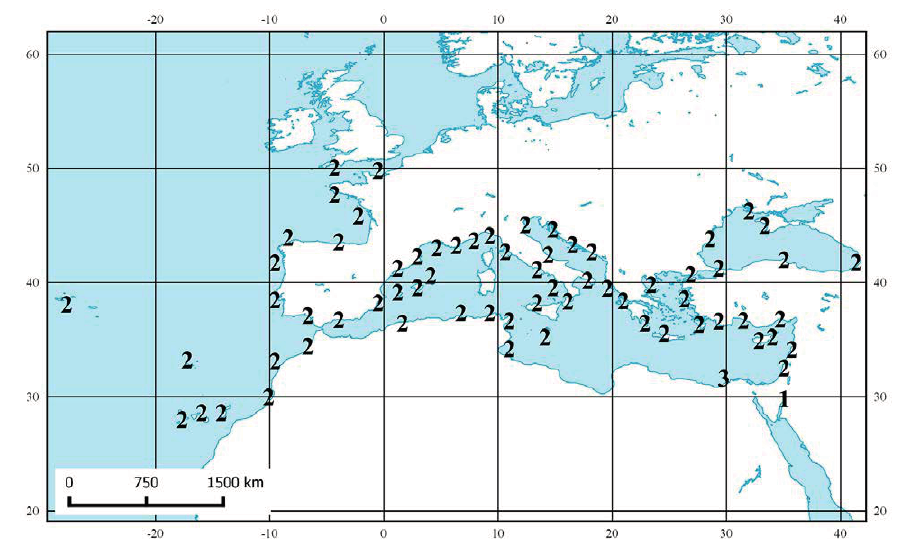
Fig. 2. – Geographical distribution of the Scorpaena decemradiata n. sp. and S. porcus Linnaeus, 1758 in the eastern Atlantic, Mediterranean Sea and Red Sea. 1, S. decemradiata n. sp., type locality; 2, S. porcus ; 3, S. porcus (probable lectotype locality of S. erythraea ). Table 2. – Comparison Scorpaena decemradiata n. sp. and S. porcus ; proportions expressed as percentage of standard length unless otherwise stated. Differences of S. porcus compared with S. decemradiata n. sp. are printed in bold face. Scorpaena decemradiata n.